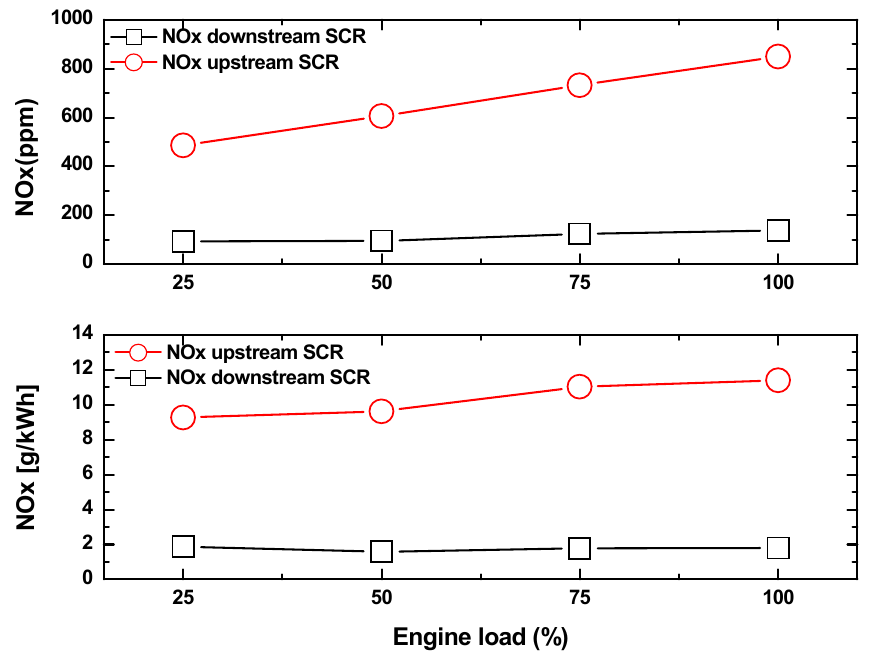
Figure 12. NOx characteristic in relation to the variation in MCR conditions.